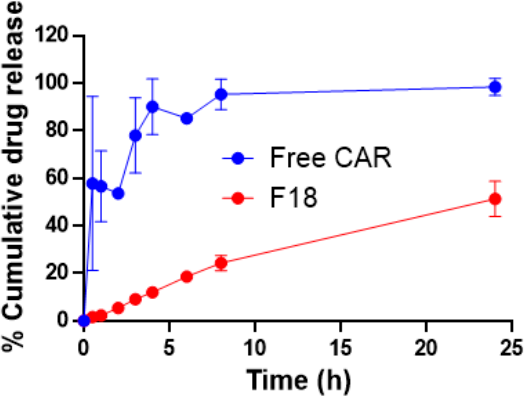
Figure 2. In vitro drug release profiles of free carvedilol dissolved in acetone and carvedilol loaded transfersome F18 ( n = 3).